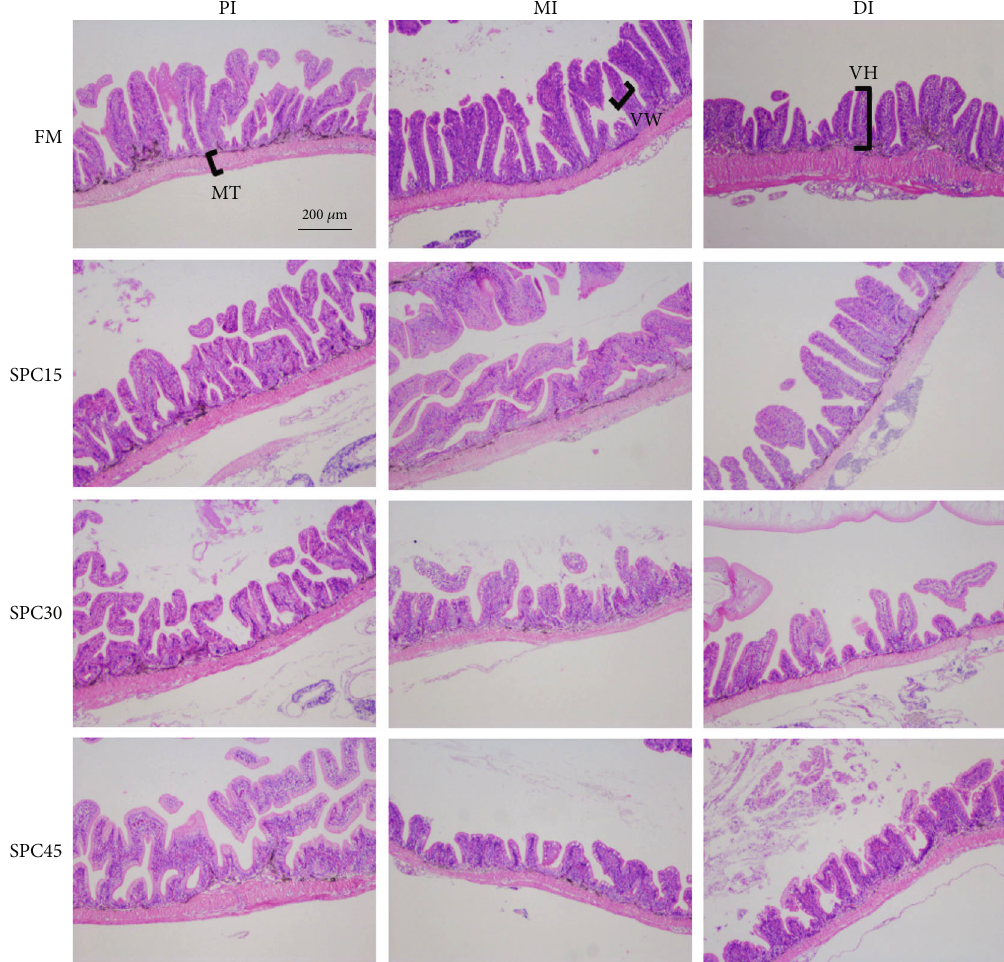
Figure 3: The intestine morphology of large yellow croakers fed the experimental diets. PI: proximal intestine; MI: middle intestine; distal intestine; VH: villi height; VW: villi length; MT: muscular thickness. Table 6: Alpha diversity index of intestinal microbiota of large yellow croaker fed the experimental diets.